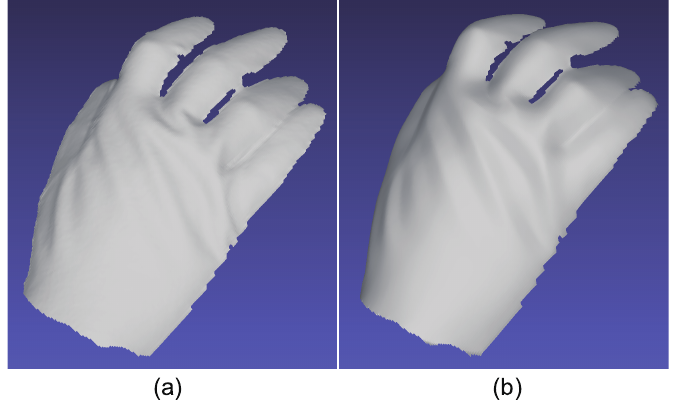
Figure 30. The results for hand with glove. Estimated geometry [pose 2]: ( a ) Estimated geometry [naive color photometric stereo] and ( b ) estimated geometry [our method]. Both color photometric stereos can estimate the surface normal of the dynamically deforming object.